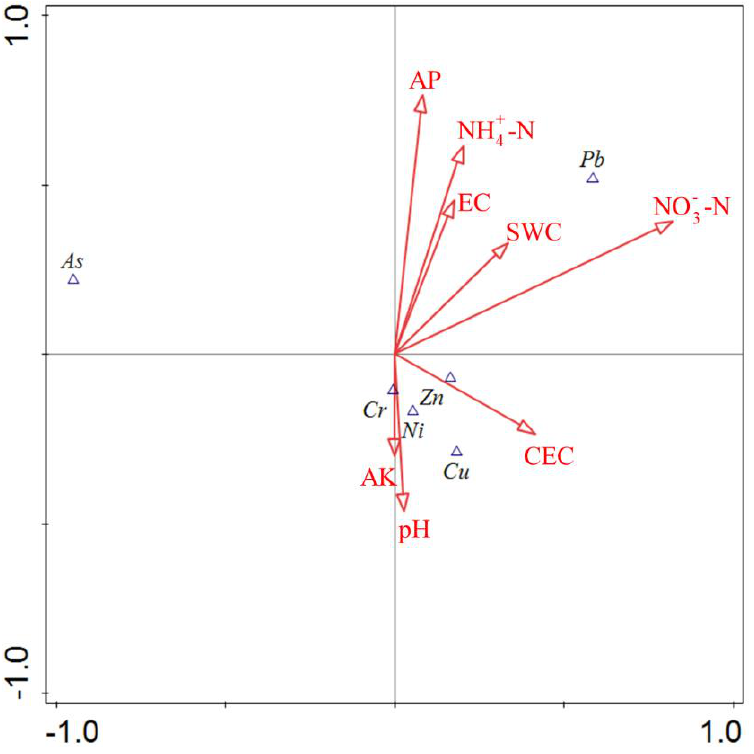
Figure 5. Figure 5. Two-dimensional ordination of CCA of soil heavy metal contents and soil physicochemical properties.